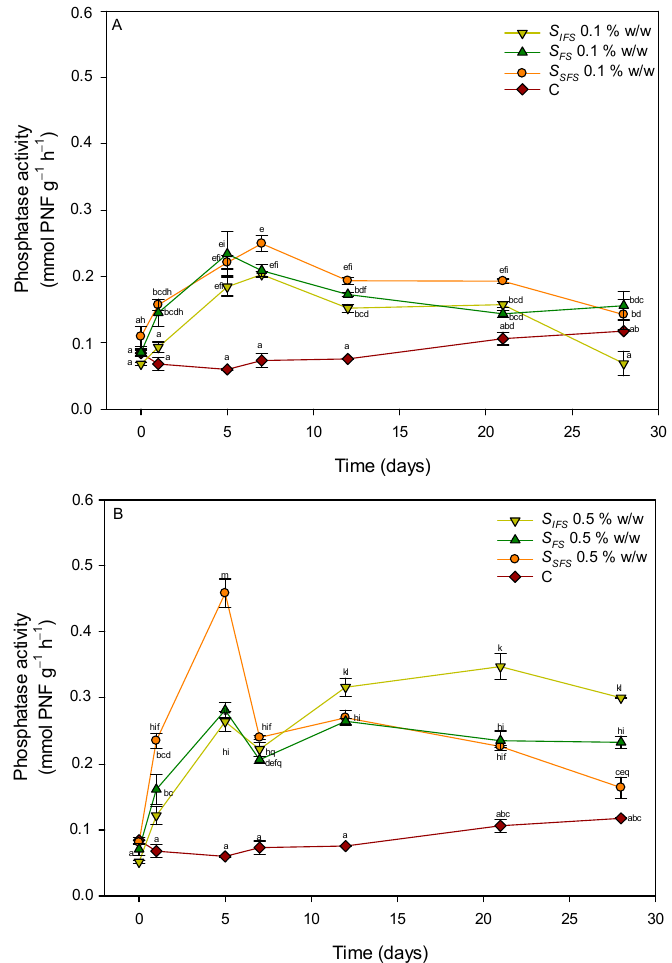
Figure 4. The phosphatase activity in the control soils and soils treated with the different products at concentrations of 0.1% w / w ( A ) and 0.5% w / w ( B ). Points (mean ± SD) with the same letter(s) were not significantly different from each other ( p > 0.05). PNF: p-nitrophenol.